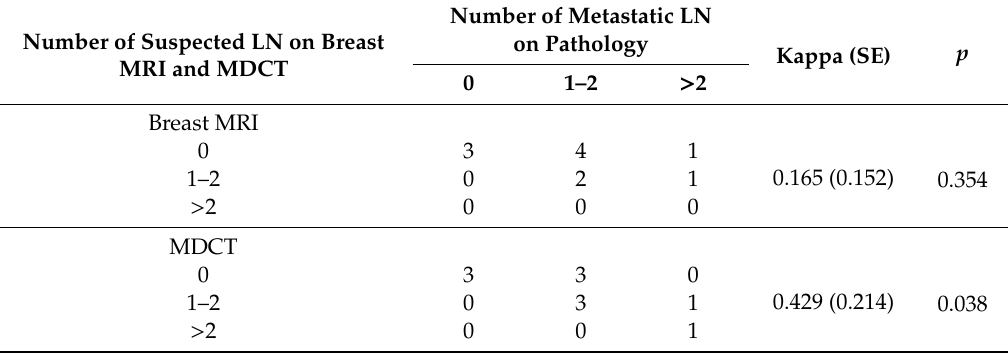
Table 3. Comparison of the number of suspected lymph nodes (LN) on breast MRI and MDCT and number of metastatic LN on pathology ( n =